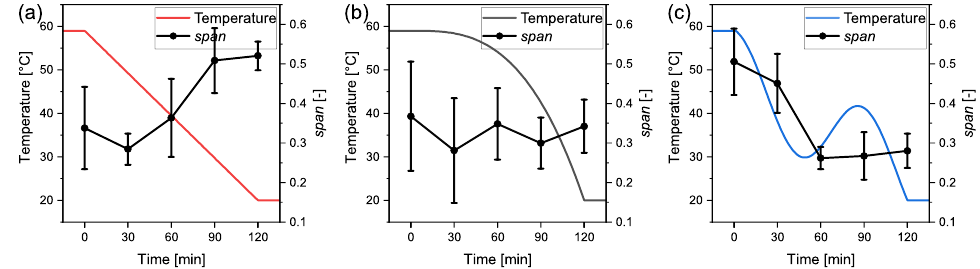
Figure 8. Span of the product crystal distributions for the considered temperature profiles ( a ) linear, ( b ) progressive, and ( c ) oscillating. Experimental values are taken from triple